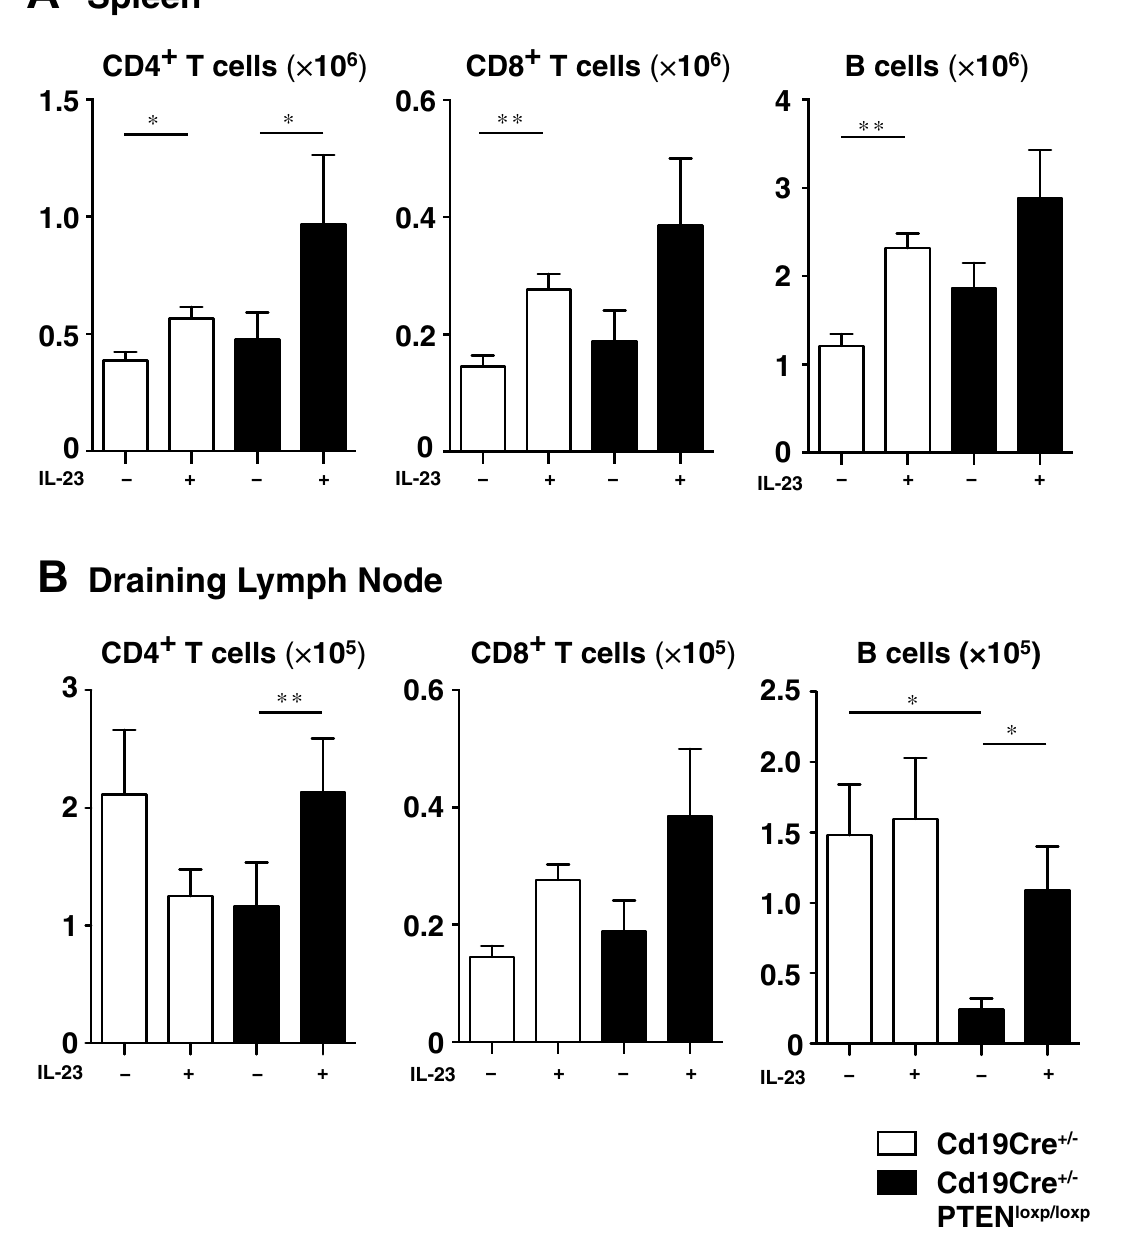
Figure 3. rmIL-23 injection increased the number of CD4 + T cells in the spleen and draining lymph nodes and B cells in the draining lymph nodes in B cell-specific PTEN-deficient mice. The number of CD4 + T cells, CD8 + T cells, and B cells in the spleen ( A ) and draining lymph nodes ( B ) of rmIL-23 injected Cd19Cre + /− and Cd19Cre + /− Pten loxP/loxP mice. Values represent means ± SEMs. Significant differences between samples means are indicated as: * P < 0.05, ** P <